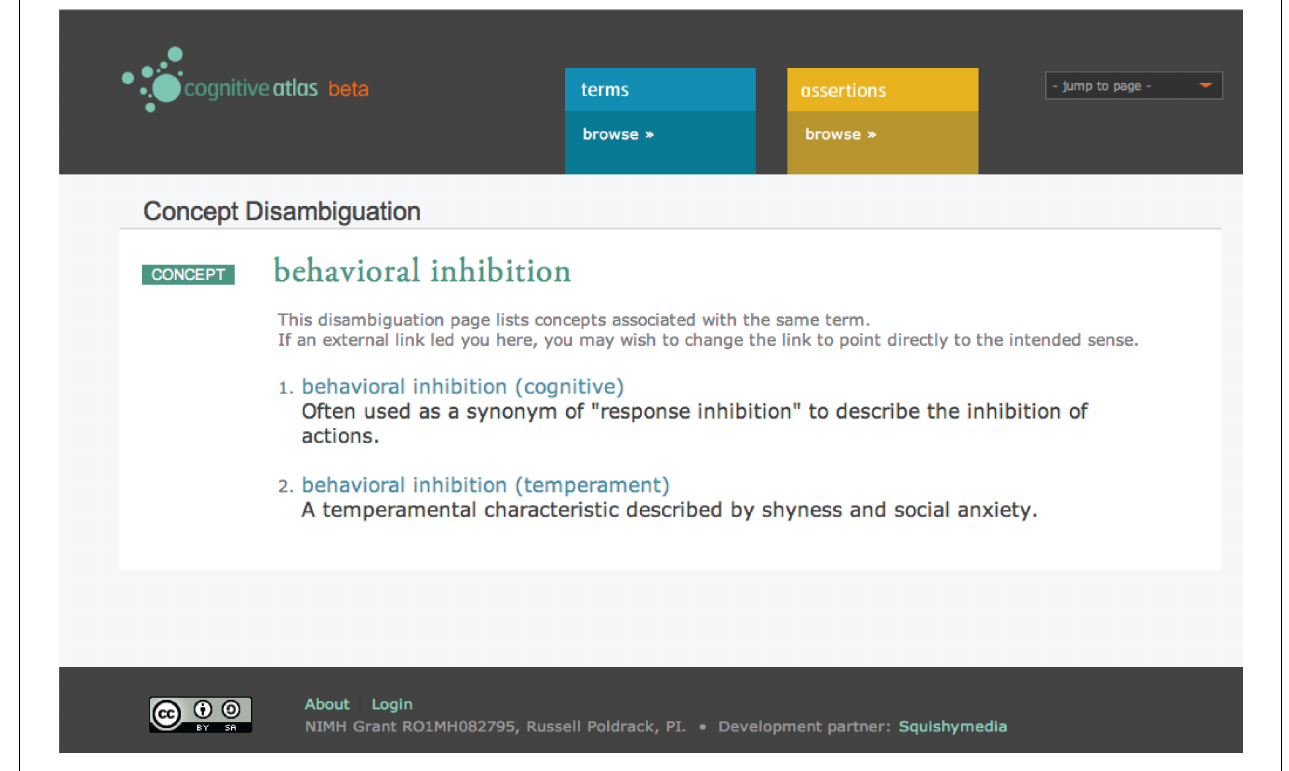
FIGURE 3 |A screenshot of the disambiguation page for the concept of “behavioral inhibition,” which points to two separate senses of the